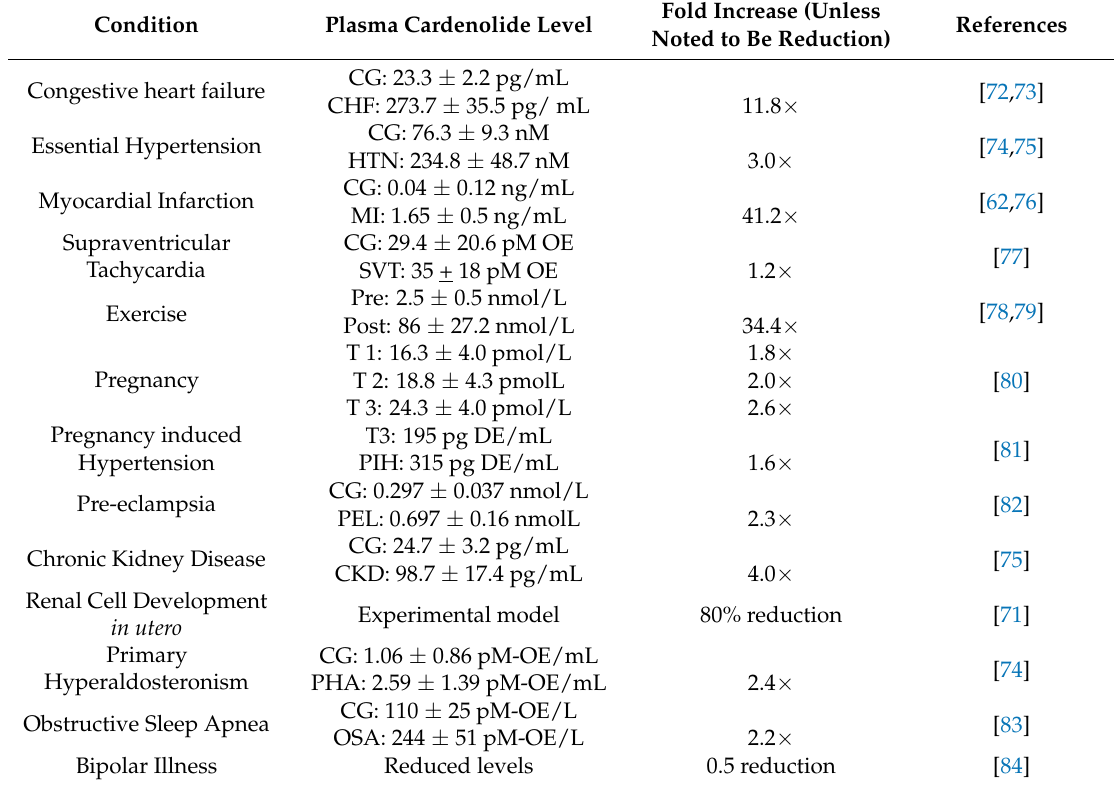
Table 1. Diseases or conditions associated with dysregulation of endogenous cardenolides. Condition Plasma Cardenolide Level